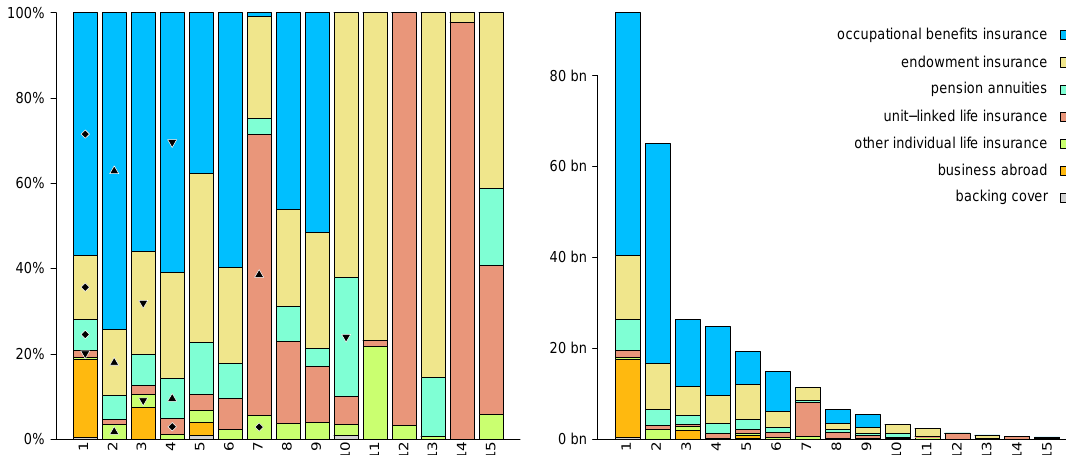
Figure A2. Life insurers’ assets ( top ), liabilities ( middle ) and insurance provisions ( bottom ) as used for the case study. Values on (lhs) are relative and in percentage, values on (rhs) are absolute and in billion CHF. For each line of business we indicate by (cid:78) , (cid:7) , (cid:72) the market shares based on earned premiums of the first, second and third largest insurer, respectively.